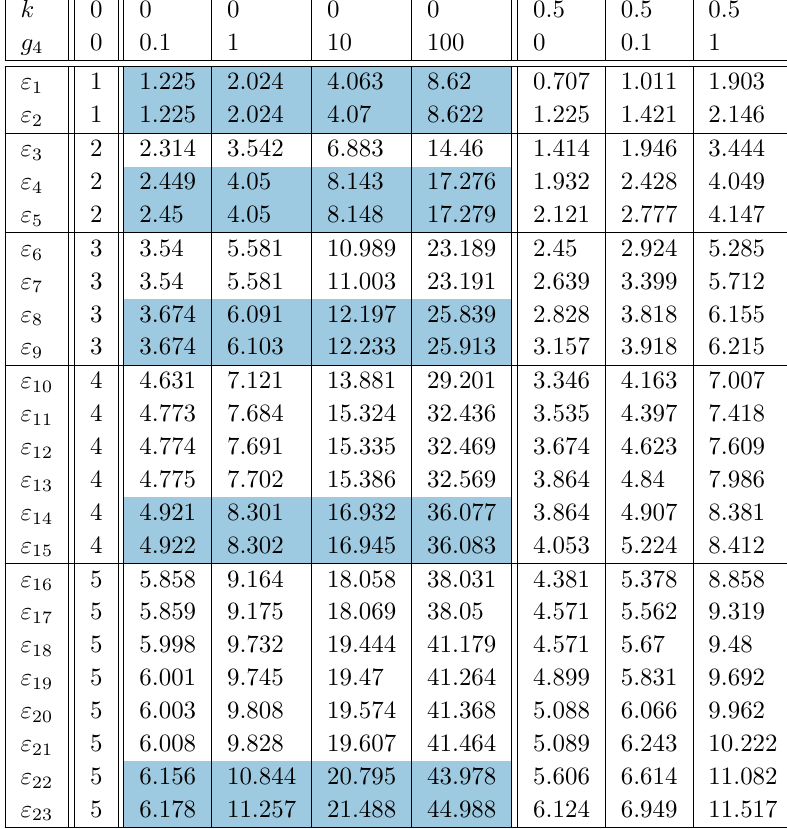
Table 14. Two-matrix spectrum with loop length truncation l = 5